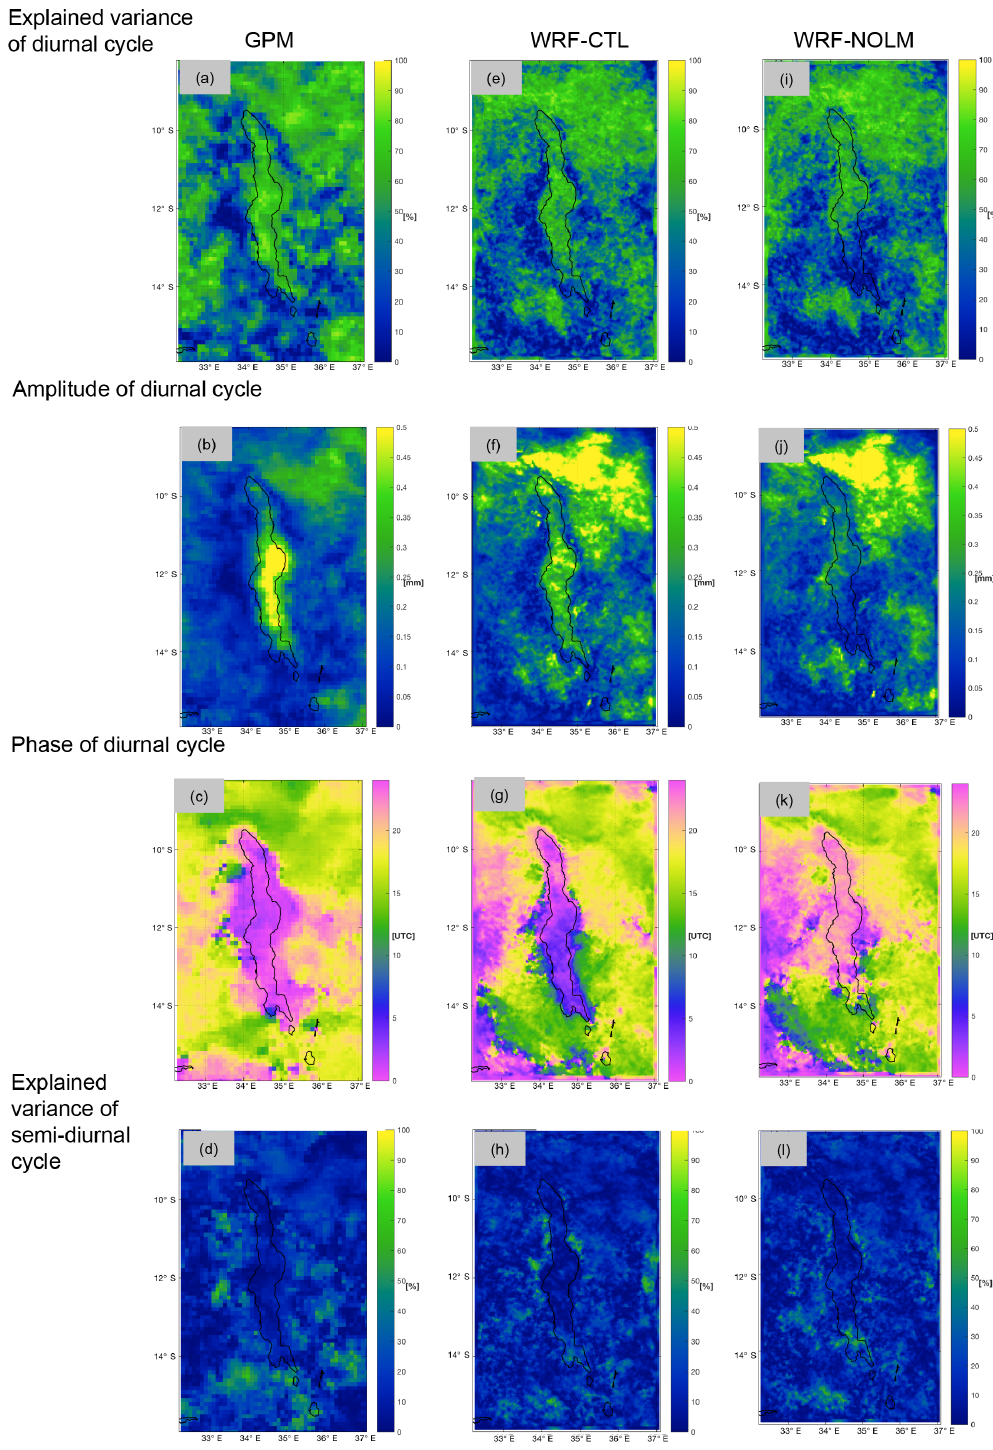
Figure 4. Characteristics of daily-scale temporal variation in precipitation estimated by harmonic analysis for (first row) explained variance of the diurnal cycle, (second row) amplitude of the diurnal cycle, (third row) phase of the diurnal cycle, and (fourth row) explained variance of the semi-diurnal cycle for (left) GPM, (middle) WRF-CTL, and (right) WRF-NOLM,